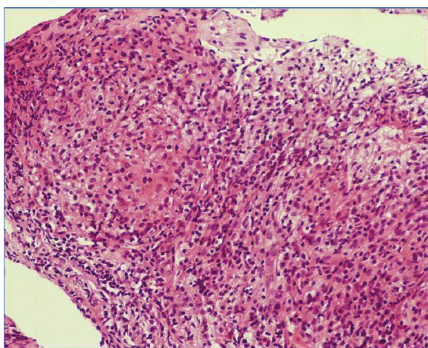
Figure 4: Histopathological examination demonstrating caseating epithelioid granulomas with lymphocytic cuffing suggestive of tuberculosis, hematoxylin-eosin (H.E.) stain ×